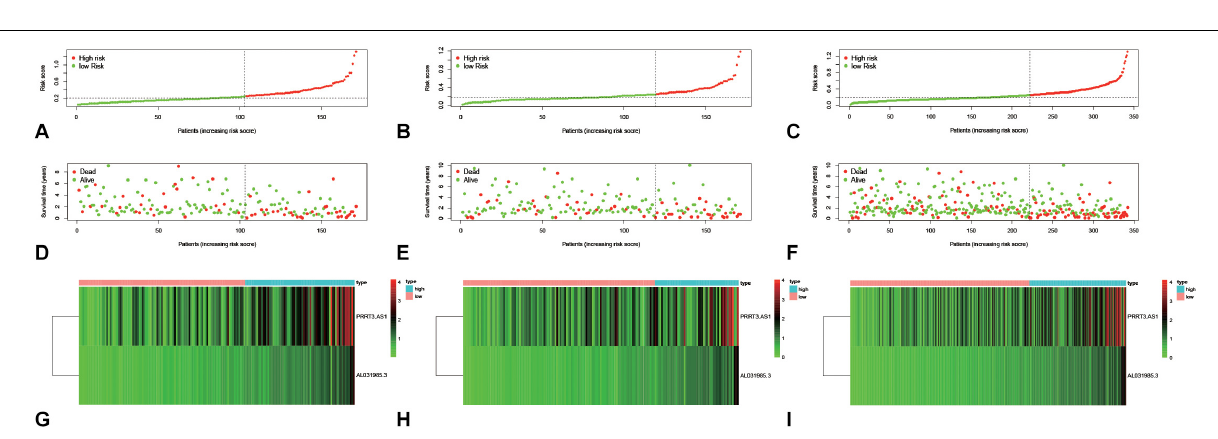
FIGURE 3 | The distribution of immune risk score (A–C) , survival status (D–F) , and expression matrix (G–I) of the two lncRNAs for HCC patients in the training group (A,D,G) , testing group (B,E,H) , and the entire group (C,F,I) .